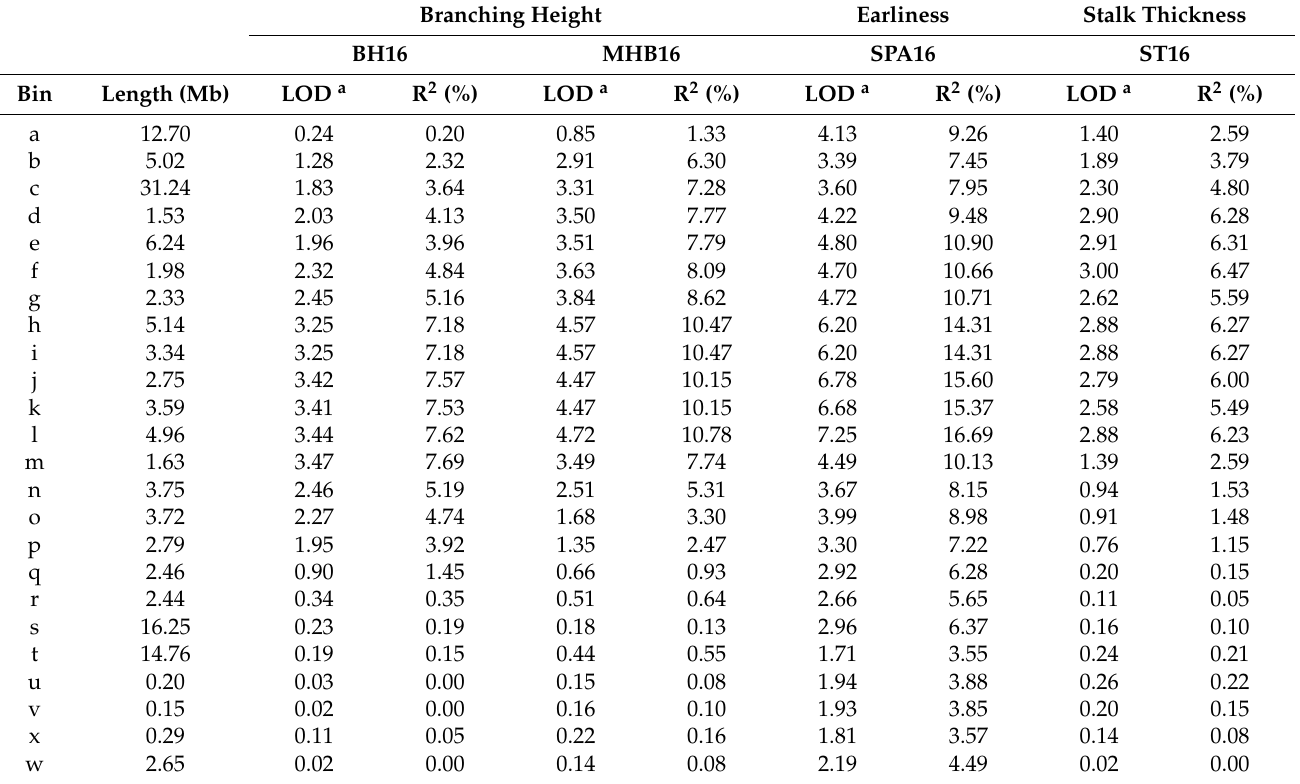
Table 4. Bins detected in chromosome 5 and QTLs identified. BH, mean branching height; MBH, maximum branching height; SPA, spear area; ST, stalk thickness. Termination 16 refers to the year 2016, when the QTLs were